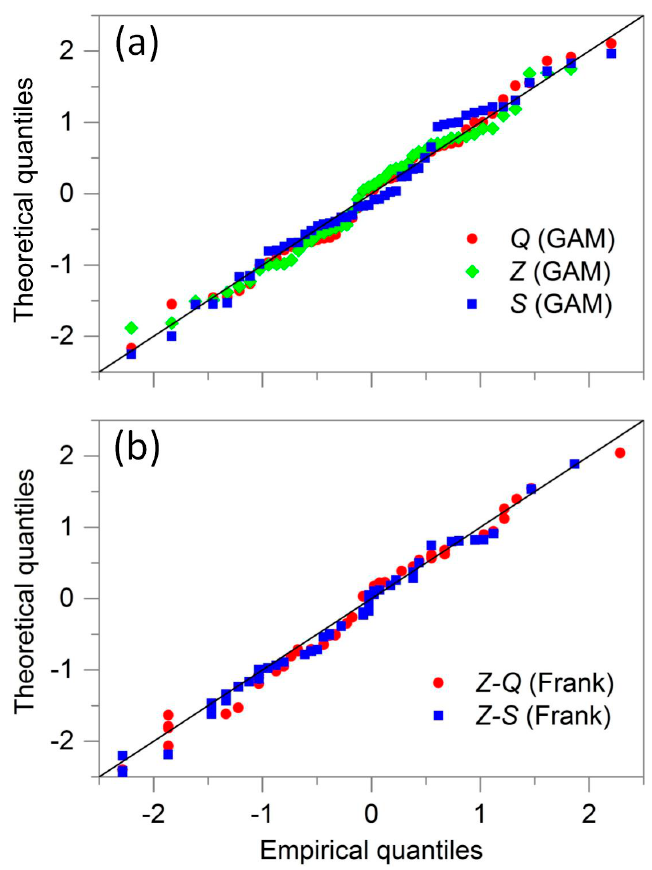
Figure 3. Quantiles–Quantiles (QQ) plot of the selected marginal distributions ( a ) and bivariate copula ( b ).